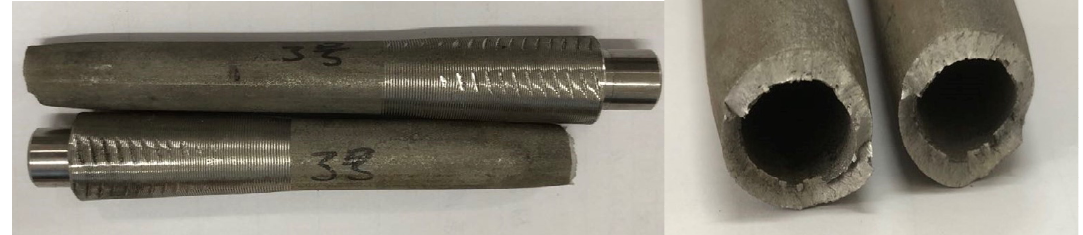
Figure 4. Tensile results of section sample and section.